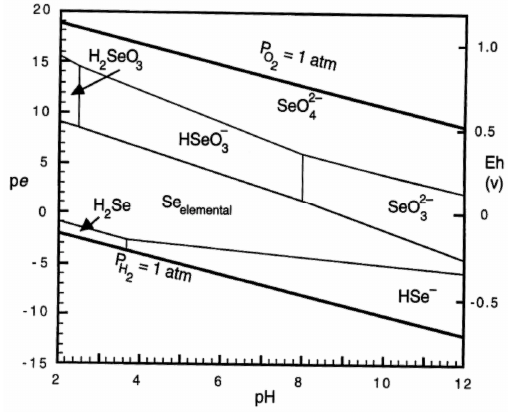
Figure 1. E h -pH diagram for the Se–O–H system [4].